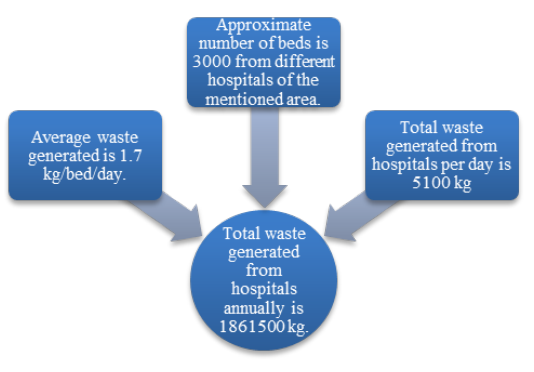
Figure 1. Details of medical waste generated at